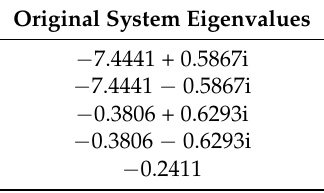
Table 1. Eigenvalues of the considered WT with DFIG system.